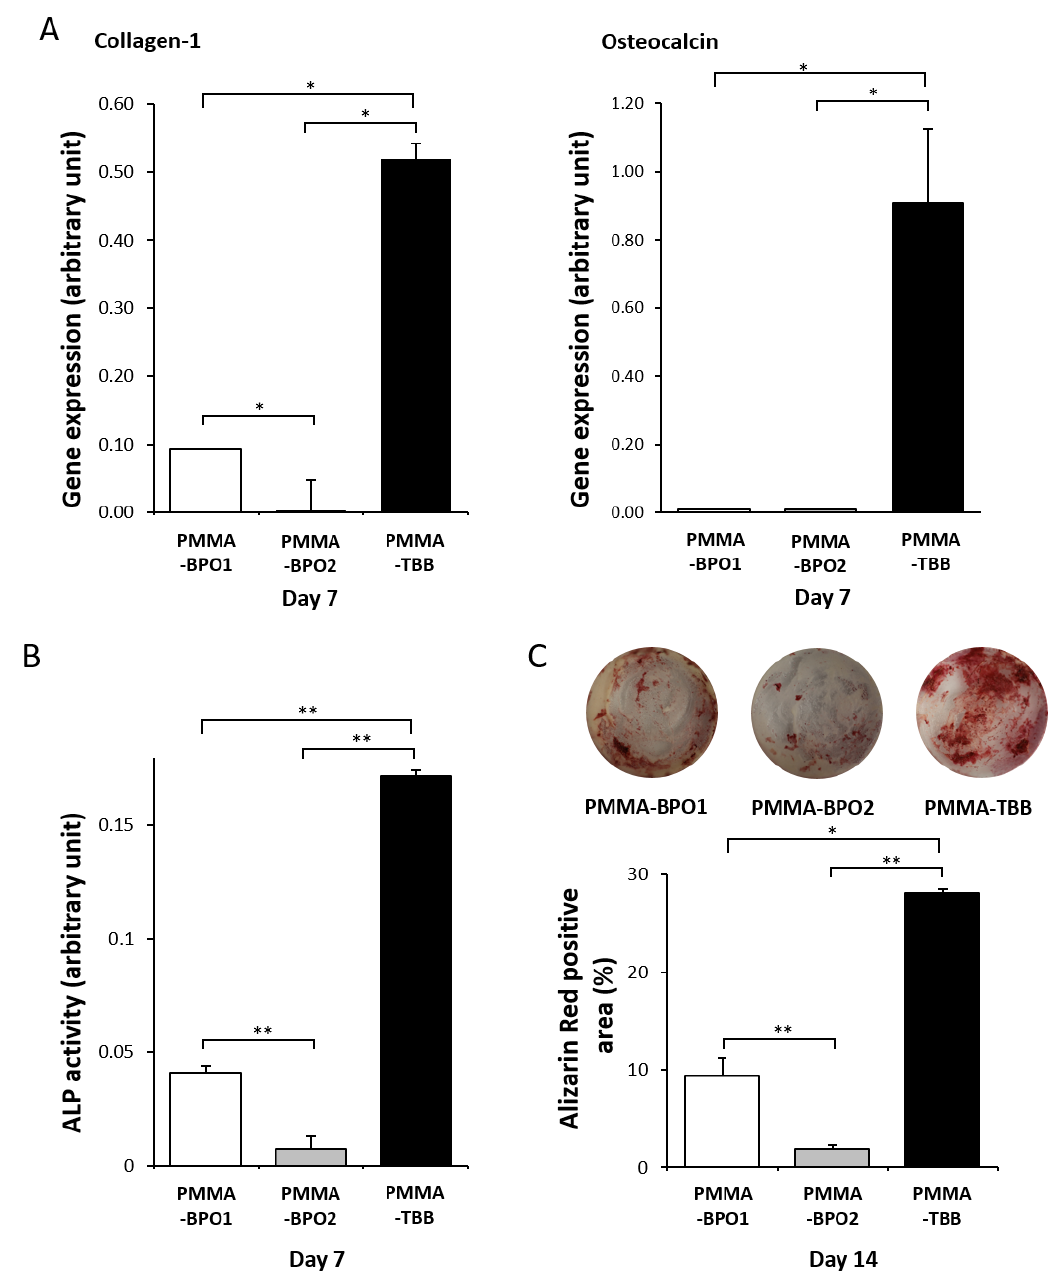
Figure 4. Biological characteristics of osteoblasts on three di ff erent bone cement surfaces. ( A ) Real-time qPCR analysis of mRNA expression of bone-related genes of collagen type I alpha 1 (collagen-1) and osteocalcin on the three di ff erent materials on day 7 using osteoblastic cell cultures. Relative expression levels (2 − ∆∆ Ct values) of the genes of interest were normalized to that of the housekeeping gene Gapdh . ( B ) Alkaline phosphatase (ALP) activity at day 7, colorimetrically quantified and standardized relative to cell number. ( C ) Representative images of mineral deposition evaluated using Alizarin red staining at culture day 14 (top). The histogram of the percentage of the Alizarin-positive area relative to total cell growth area on a culture well on the same day (bottom). Each value represents the mean ± standard deviation of triplicate experiments ( n = 3). * p < 0.05, ** p < 0.01, one-way ANOVA followed by a Bonferroni test.